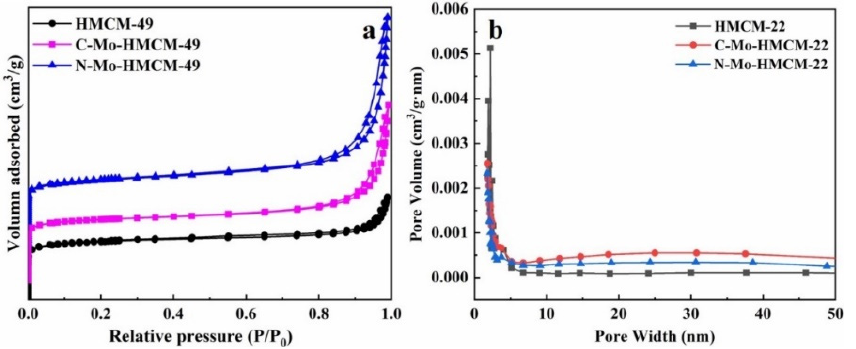
Figure 5. N 2 -adsorption ( a ) and desorption and pore size distributions ( b ) of HMCM-49, C-Mo- HMCM-49 and N-Mo-HMCM-49.